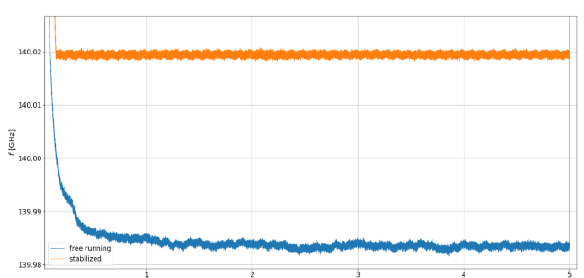
Fig. 6. Frequency as a function of time of a free running gyrotron in blue and a frequency stabilized gyrotron in